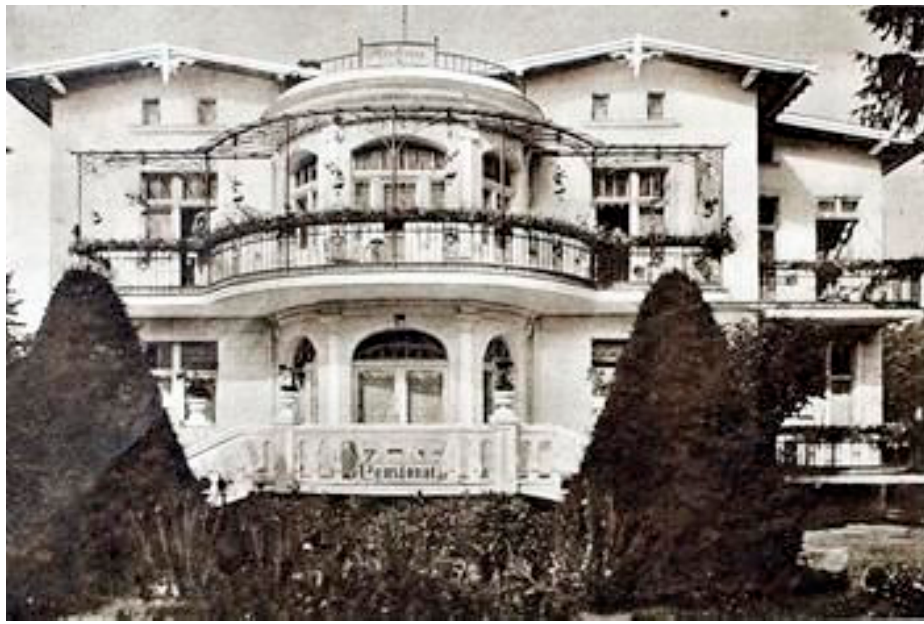
Figure 6. Willa Halina seen from the front. Photo from 1934. Source: http://www.dawnysopot.pl/index.php?content=przewodnikopis&obiekt=willahalina. (accessed on 29 April 2021)